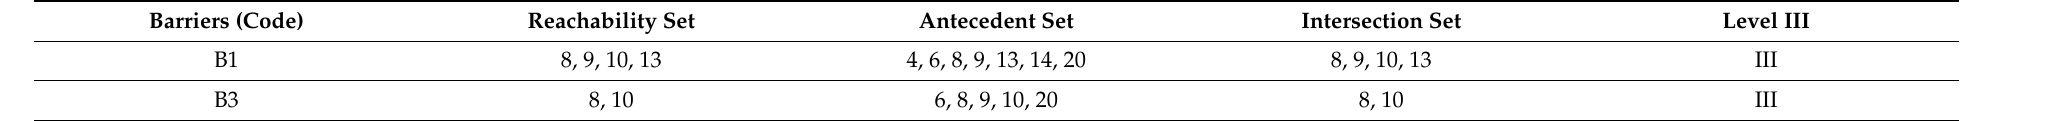
Table 8. RM level partition